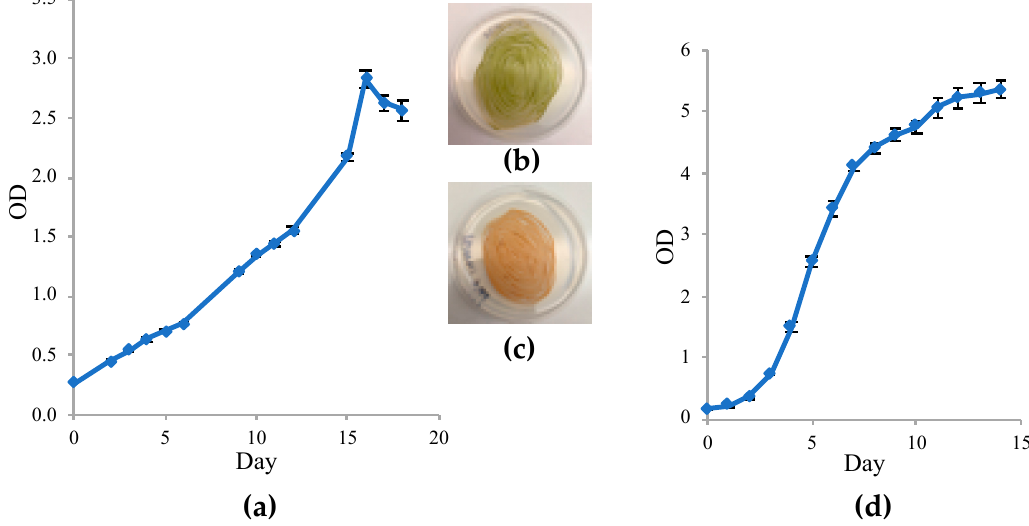
Figure 3. Growth curves of the two microalgal isolates. ( a ) growth curve of N. salina nl6 in liquid medium (n = 3, 24‰ NaCl, F/2 medium, 200 µmol m − 2 s − 1 ); ( b ) Agar plate of nl6 after 10 days growth; ( c ) Agar plate of nl6 after several weeks of growth; ( d ) growth curve of Desmodesmus sp. nl3 in liquid medium (n = 3, TAP medium, 200 µmol m − 2 s − 1 ).